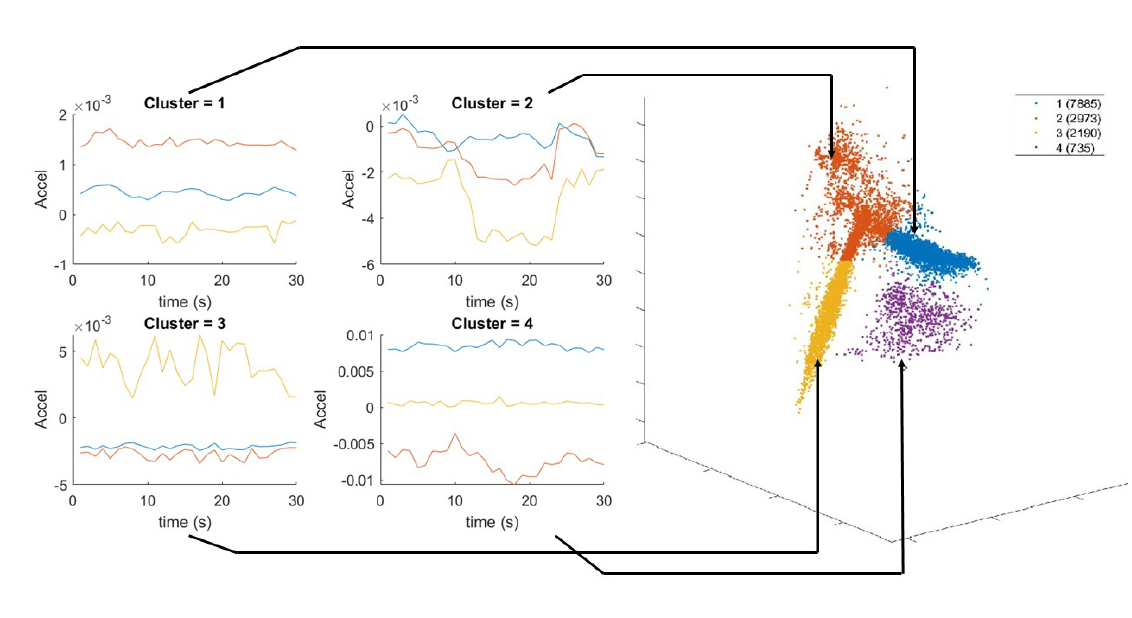
Figure 3. Example 30 s windows of accelerometer data after LPP reduction corresponding to each respective activity cluster. The orange, blue, and yellow curves represent the time series of the three dimensions of the accelerometer data after dimensionality was reduced from 21 to